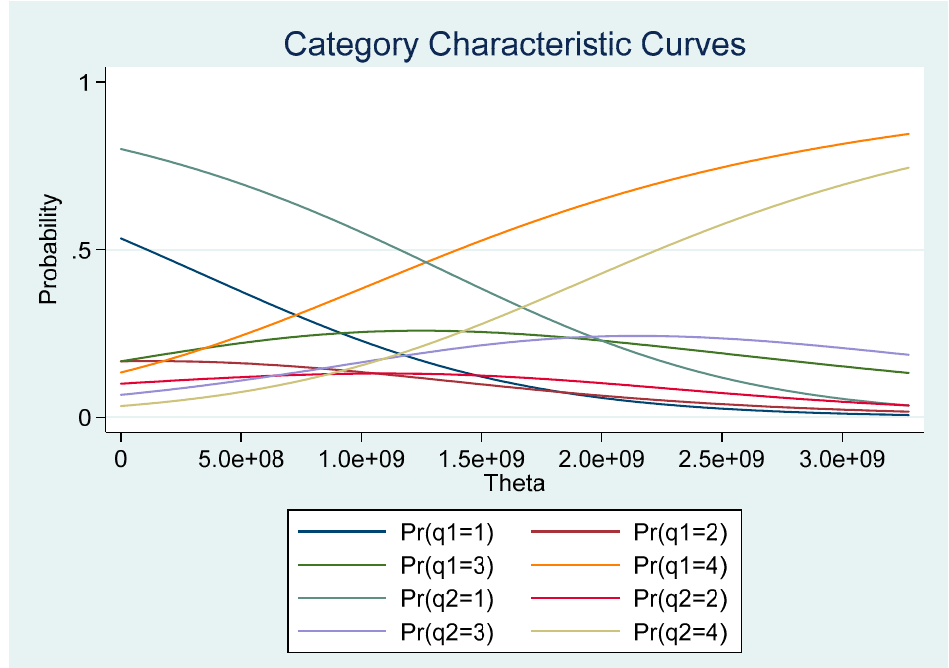
Figure 1. Category characteristic curves.